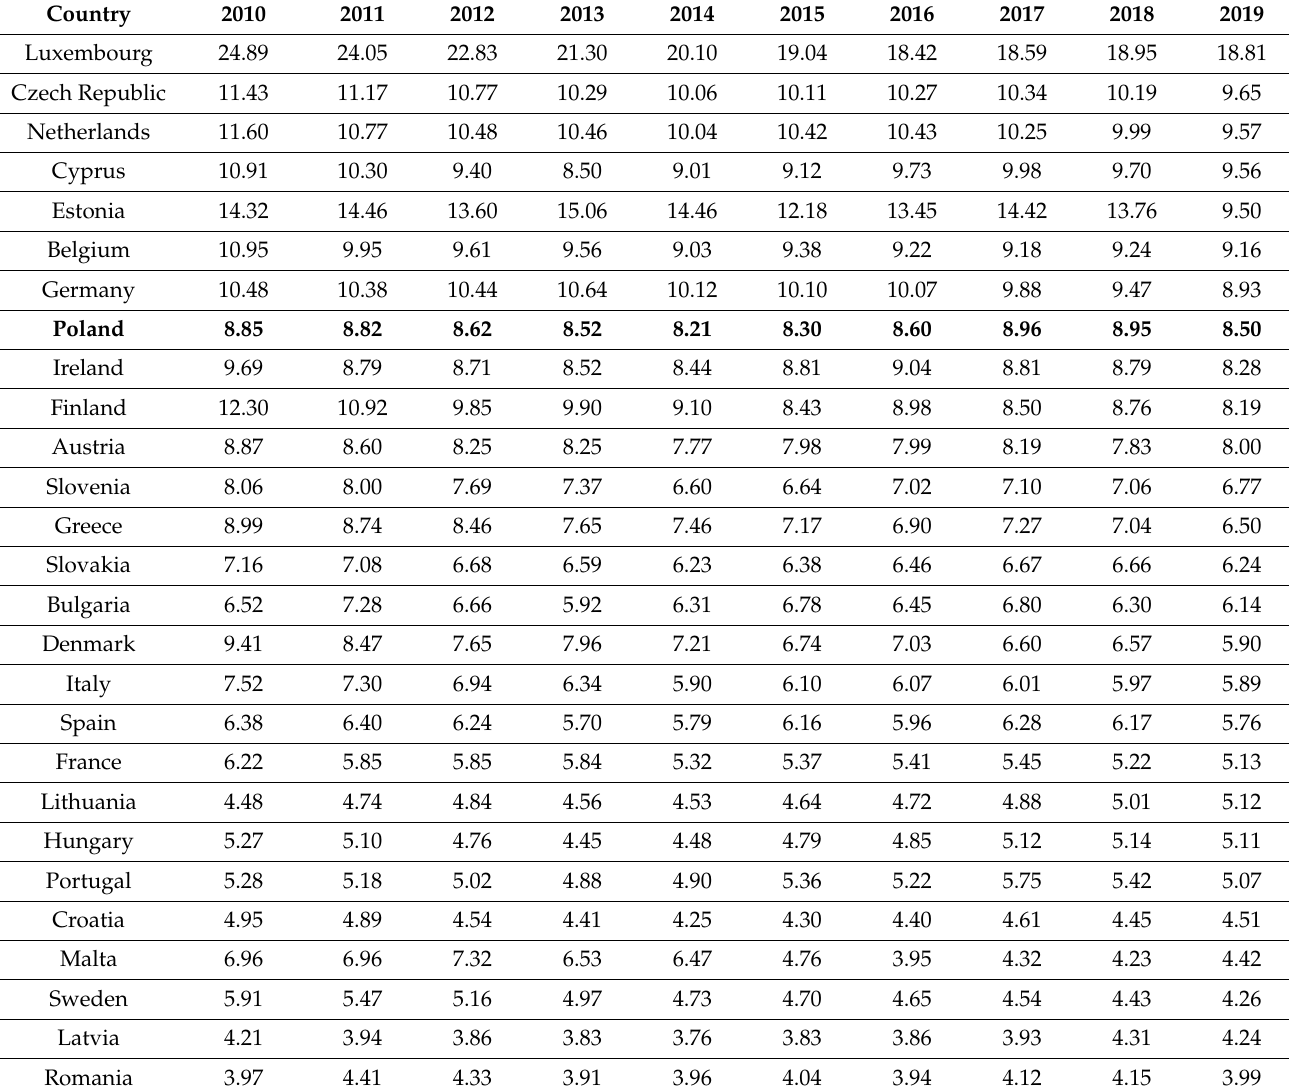
Table 2. Level of CO 2 emissions per capita (in tons) in Poland and other EU countries.